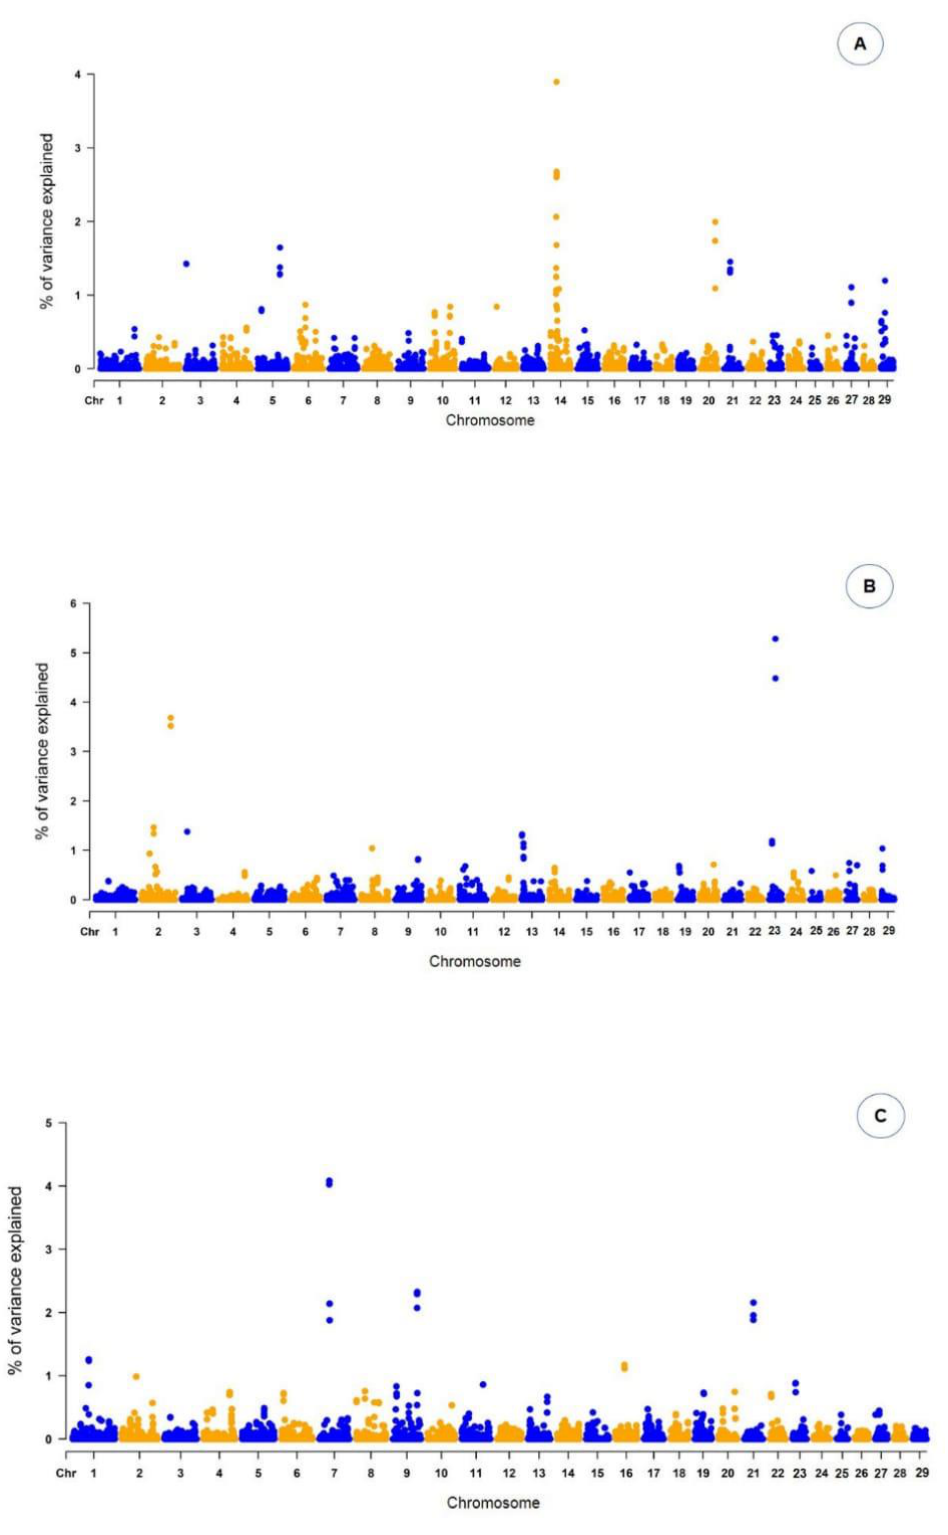
Figure 1. Manhattan plot of the percentage of the total additive genetic variance explained by windows of 10 adjacent SNPs for conformation ( A ), precocity ( B ) and muscling ( C ) scores in Nellore cattle. X-axis: autosomes. Y-axis: percentage of additive genetic variance explained .